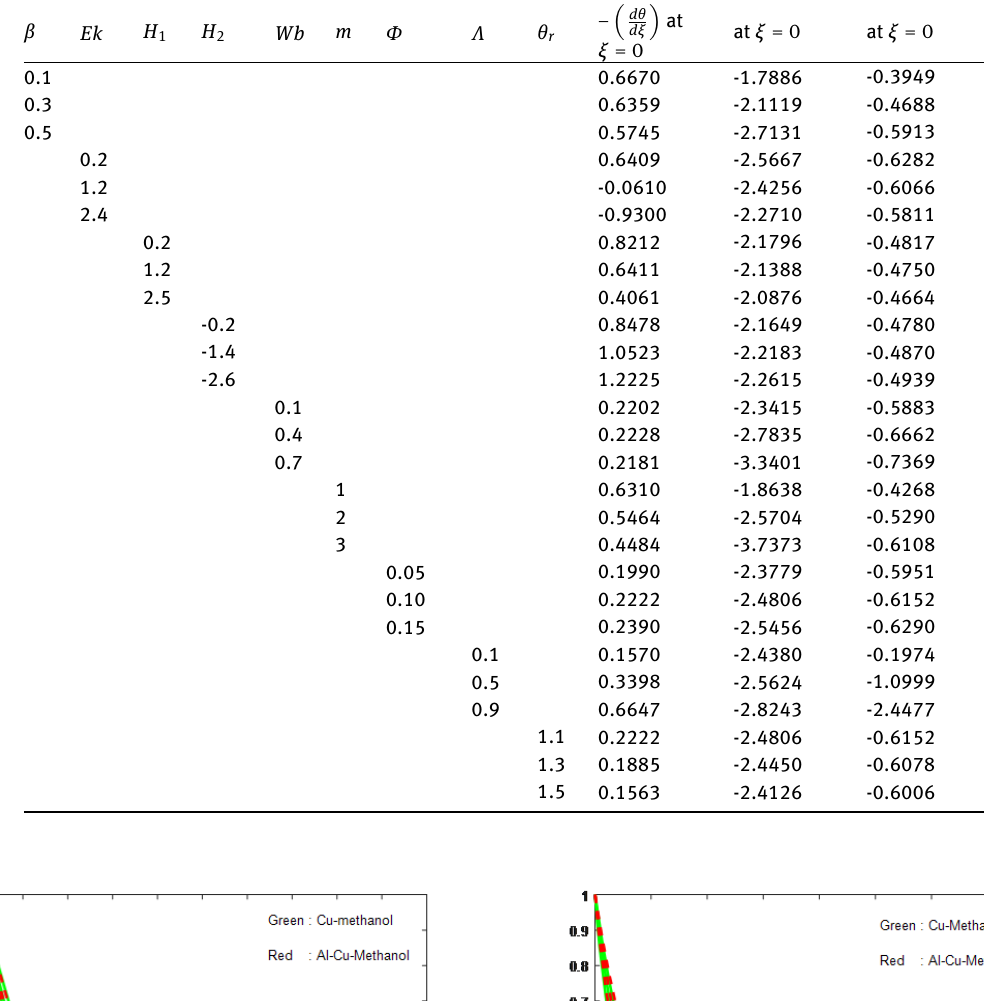
(cid:16) (cid:17) (cid:16) d 2 f (cid:17) (cid:16) d 2 g (cid:17) , , at reckoned utilizing Eqs. (13)-(15), for Cu-methanol liquid flow dθ dξ dξ 2 dξ 2